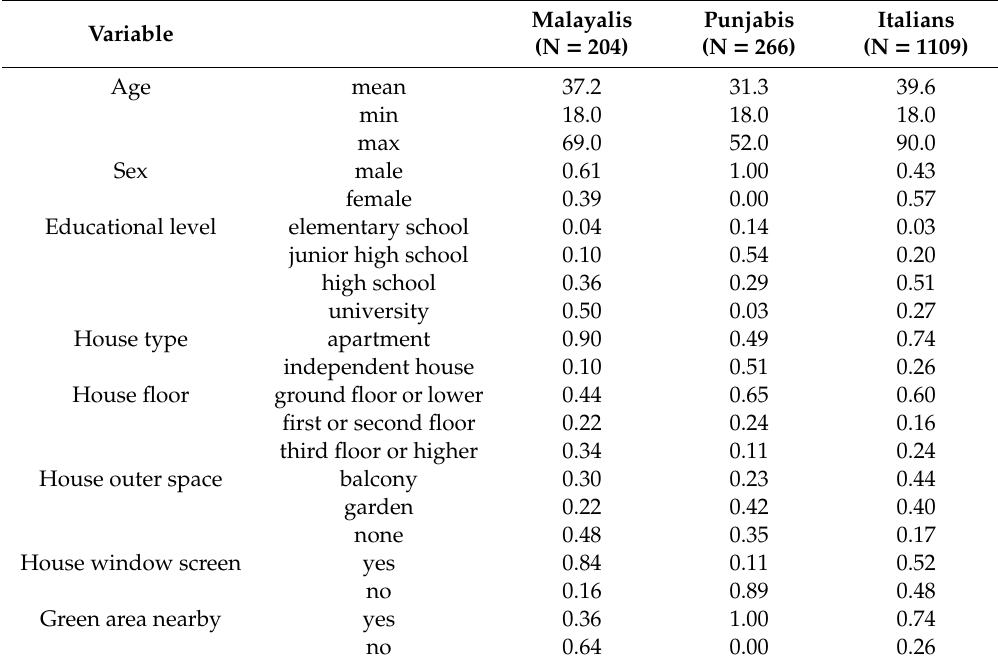
Table 1. Descriptions of socio-demographics and house characteristics in the three